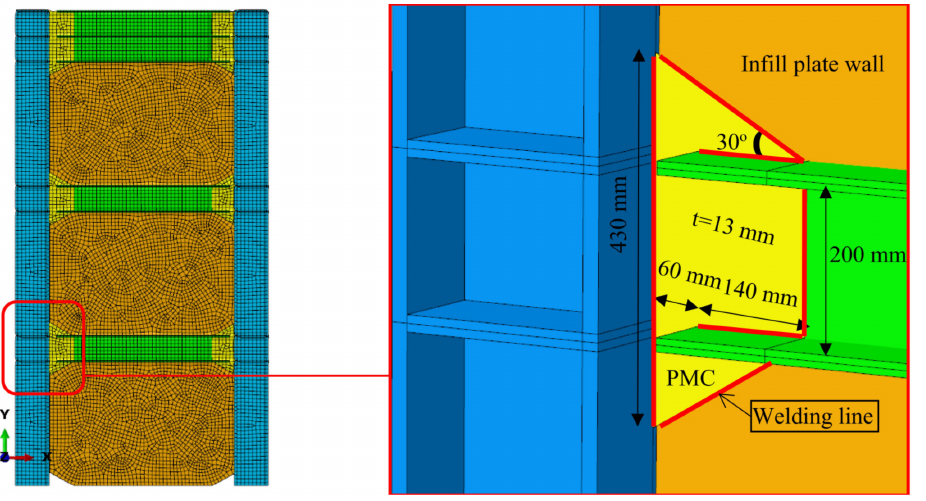
Figure 9. Geometrical features and location of the absorber plate in the steel plate shear walls (SPSW)